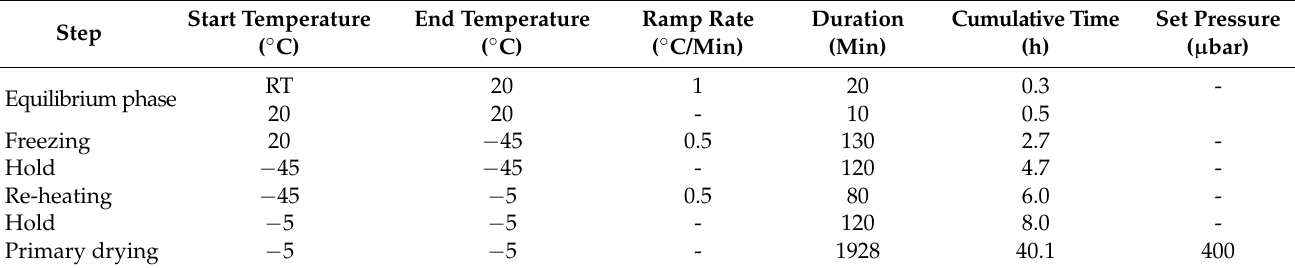
Table 2. Freeze-drying protocol for 3 g of double distilled water in 160 × 10R vials.